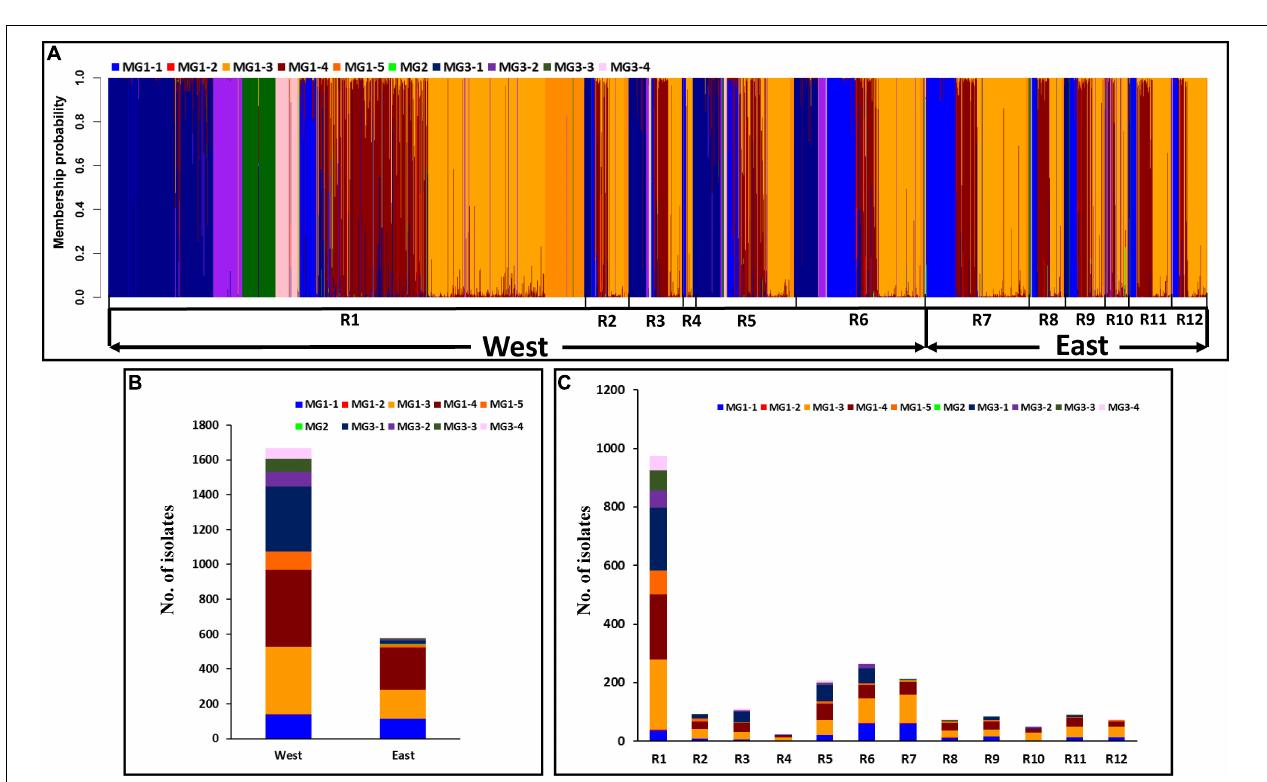
FIGURE 6 | Membership probability of each Puccinia striiformis f. sp. tritici ( Pst ) isolate in the 10 submolecular groups (MGs) from discriminant analysis of principal components (DAPC) analysis. Pst isolates are organized by epidemiological regions given at the bottom (A) . Histogram of the number of isolates clustered in the 10 molecular groups from West and East populations (B) . Distribution of the number of isolates clustered in the 10 molecular groups across 12 epidemiological regions (R1–R12) in the United States (C)